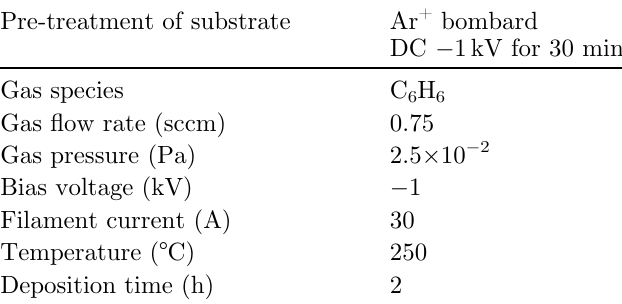
Table 2. Conditions of DLC deposition by I-PVD process. Pre-treatment of substrate